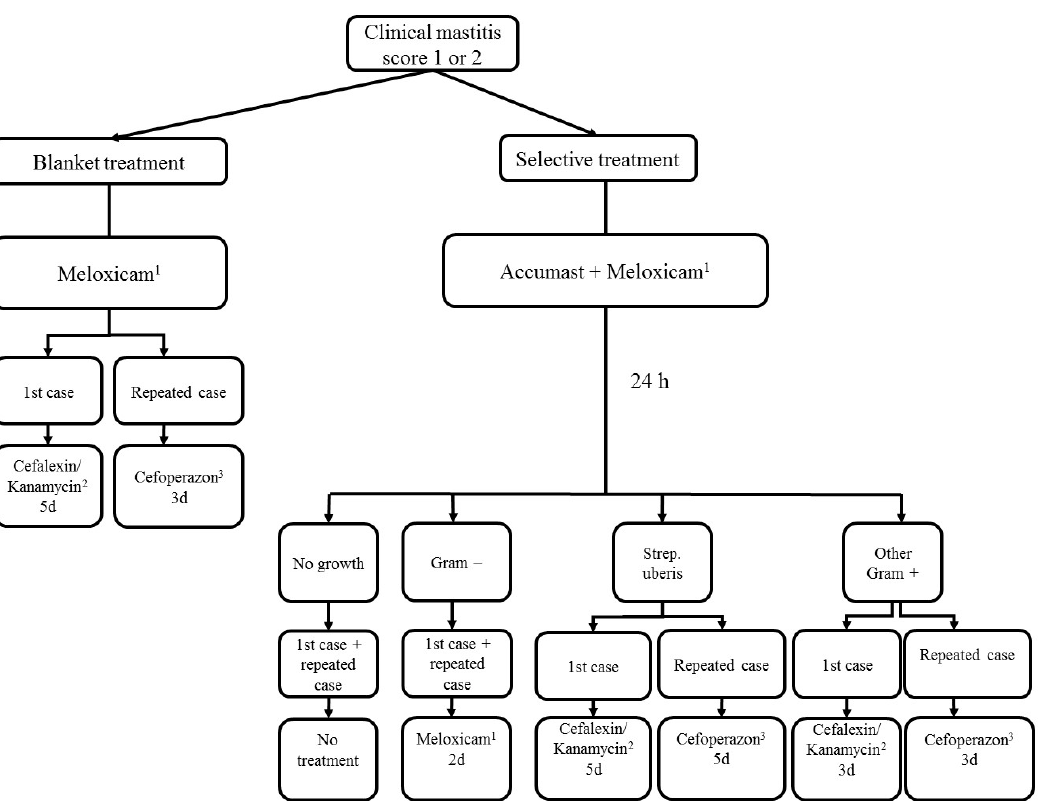
Figure 1. Schematic presentation of the treatment protocols assigned to blanket treatment and selective treatment. 1 Metacam, Boehringer-Ingelheim, Ingelheim, Germany. 2 Ubrolexin, Boehringer-Ingelheim, Ingelheim, Germany. 3 Peracef, Zoetis, Berlin,